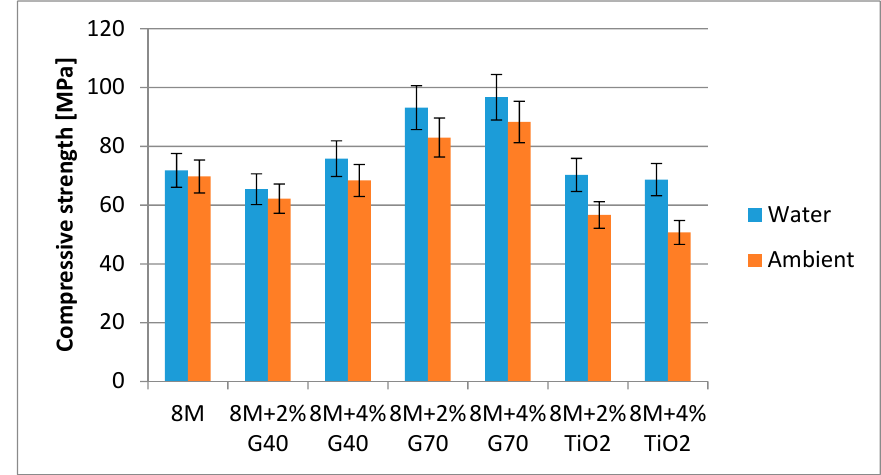
Figure 9. Results of geopolymer compressive strength after 60 days.